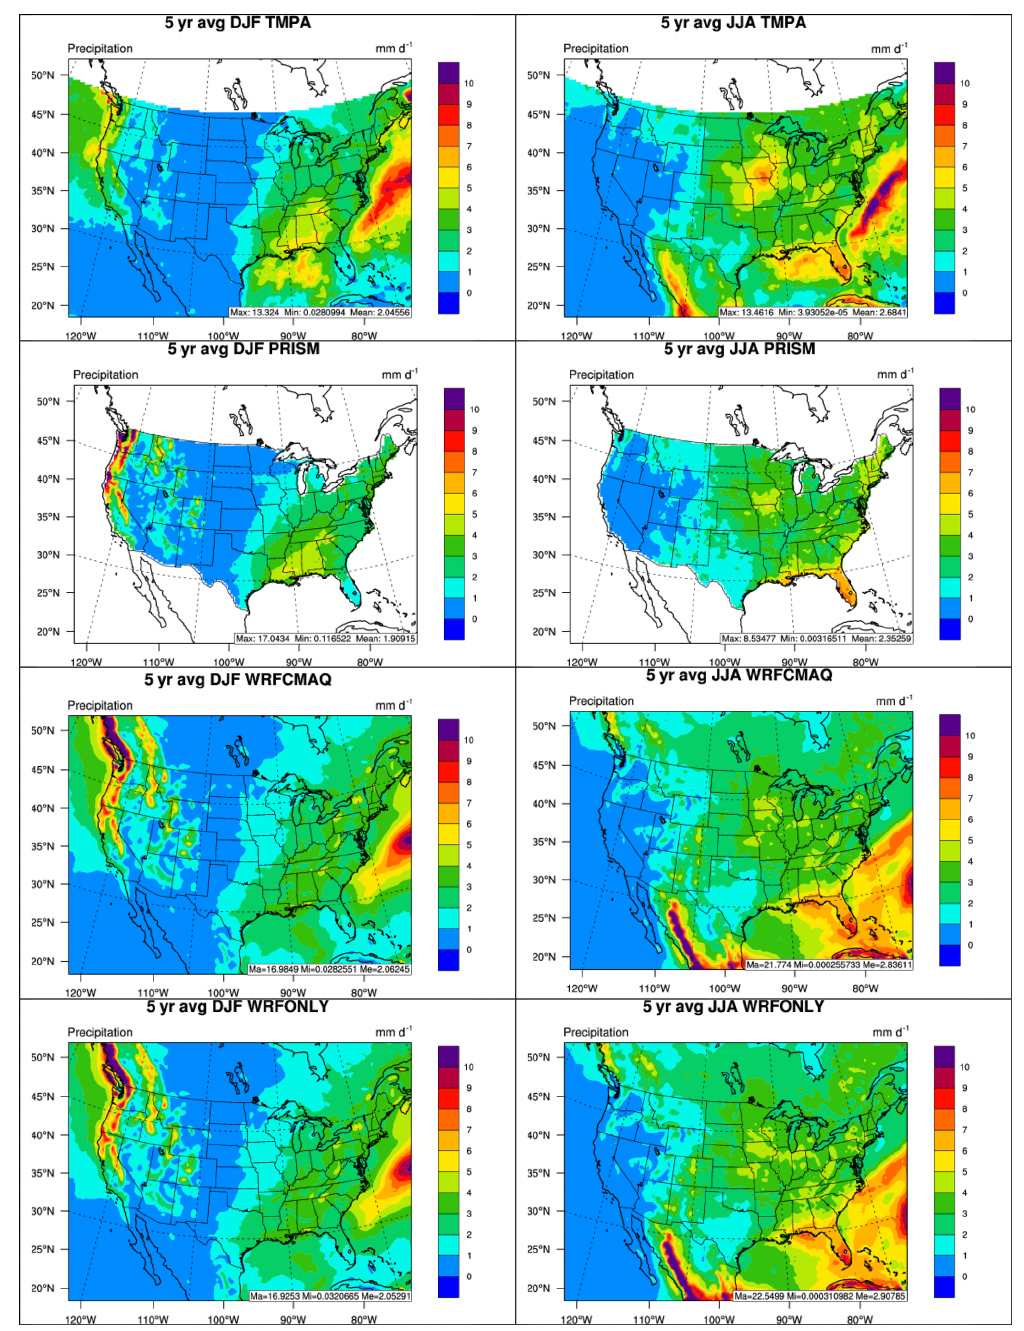
Figure 2. Spatial distributions of 5-year average of daily precipitation from TMPA, PRISM, two-way WRF-CMAQ, and WRF-only (from top to bottom) in winter (left column) and summer (right column)